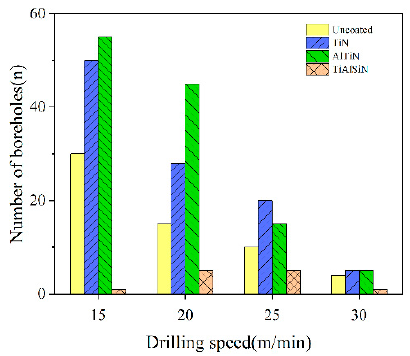
Figure 3. Drill life of all coated drills (Feed speed of 0.04 mm/r).